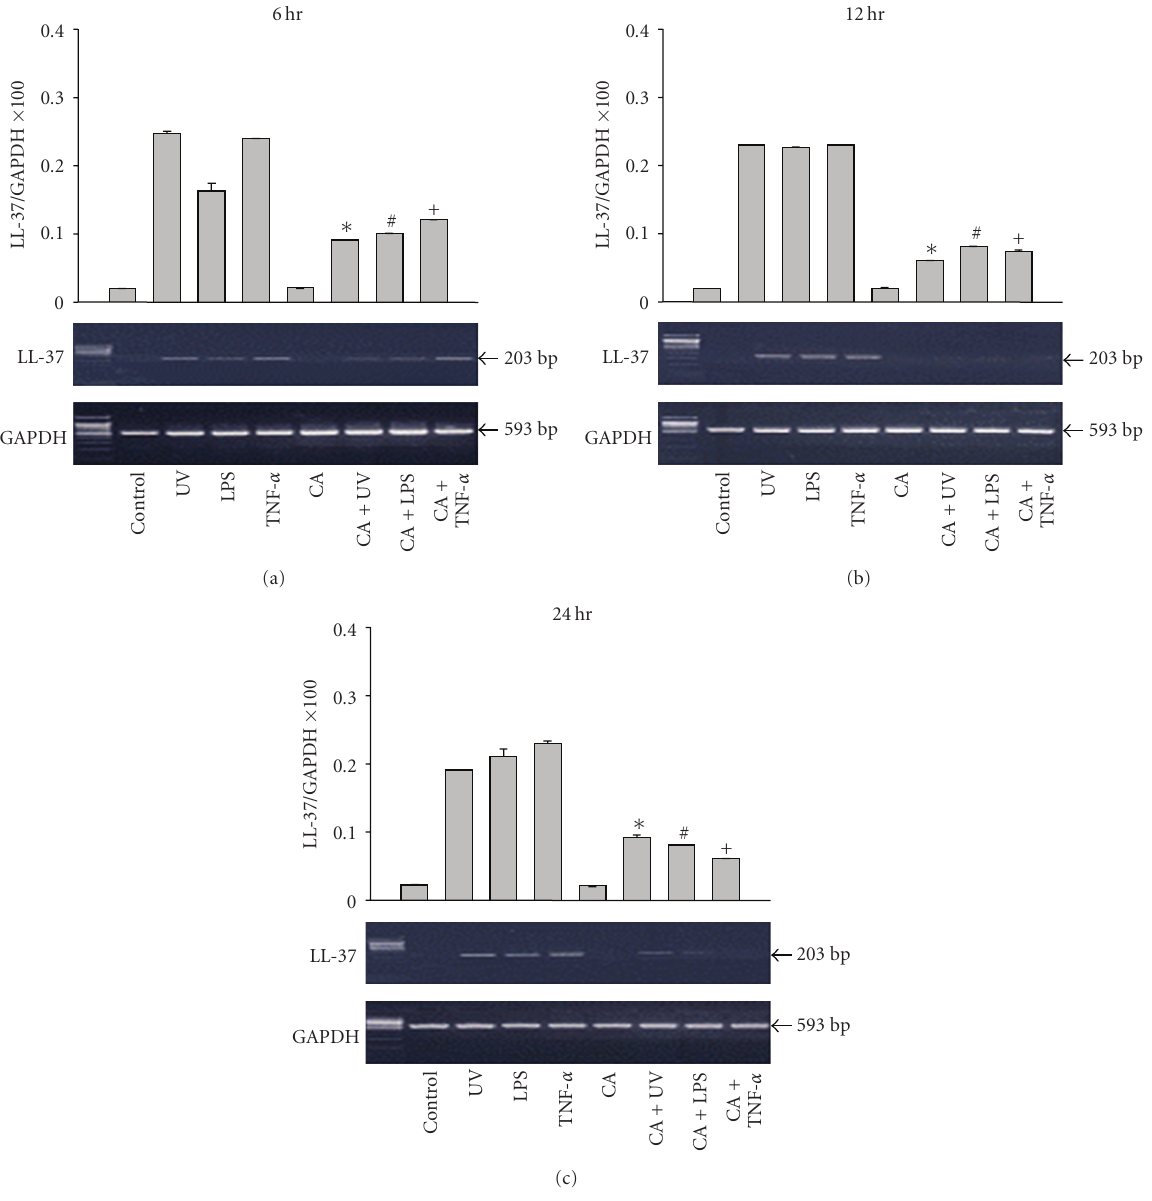
Figure 4: The expression of LL-37 mRNA in the keratinocytes was also upregulated when stimulated with LPS, TNF- α , and UVB irradiation at 6, 12, and 24 hours. Similar to the hBD-2 results, LL-37 mRNA expression decreased after treatment with calcipotriol. ∗ : Statistically significant between UV and CA + UV ( P < . 01). #: Statistically significant between LPS and CA + LPS ( P < . 01). +: Statistically significant between TNF-s and CA + TNF-a ( P < .